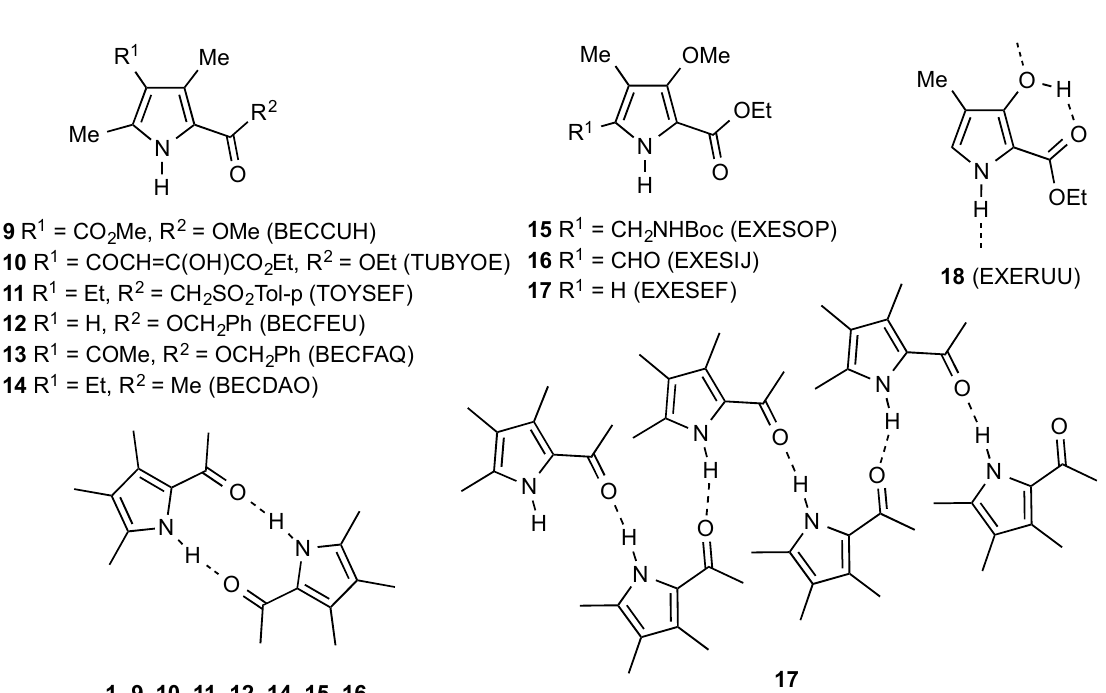
Figure 3. A survey of crystallographically characterised 2-acylpyrroles with CSD reference codes and the commonly occurring dimer and linear hydrogen-bonded structures.